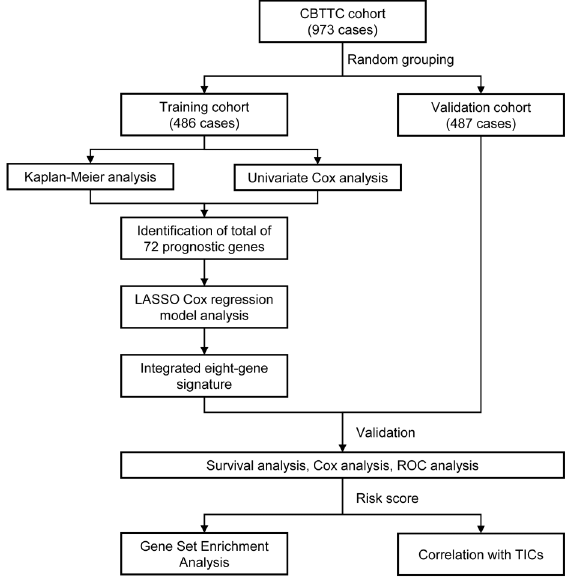
Figure 1. Flow chart of the study. The study was carried out in Pediatric Brain Tumor Atlas (CBTTC) cohort. The training cohort was used to identify prognostic genes. The LASSO regression model was used to establish a prognostic signature based on the prognostic genes. The prognosis analysis was validated in the validation cohort. LASSO: least absolute shrinkage and selection operator Cox regression model; ROC: receiver operating char- acteristic; TICs: tumor-in fi ltrating immune cells. Construction of prognostic signature from the training cohort